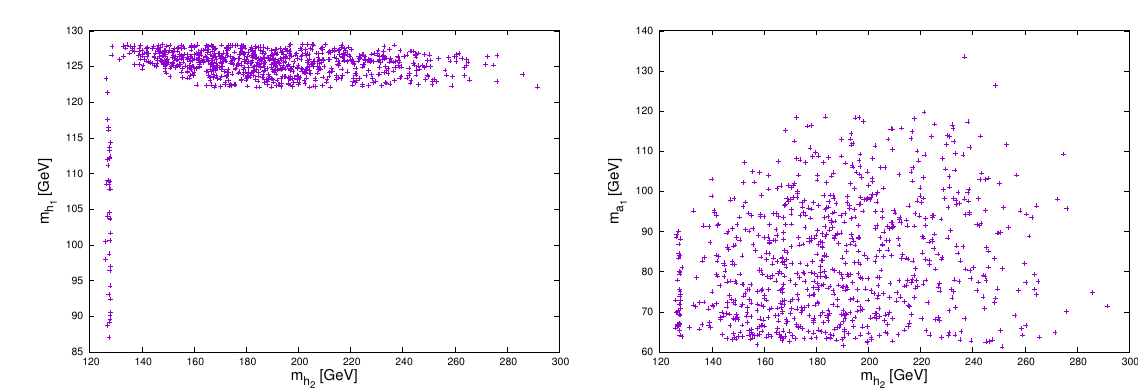
Figure 8. The mass distribution for the next-to-lightest CP-even Higgs, m h versus the lightest CP-odd Higgs mass m a